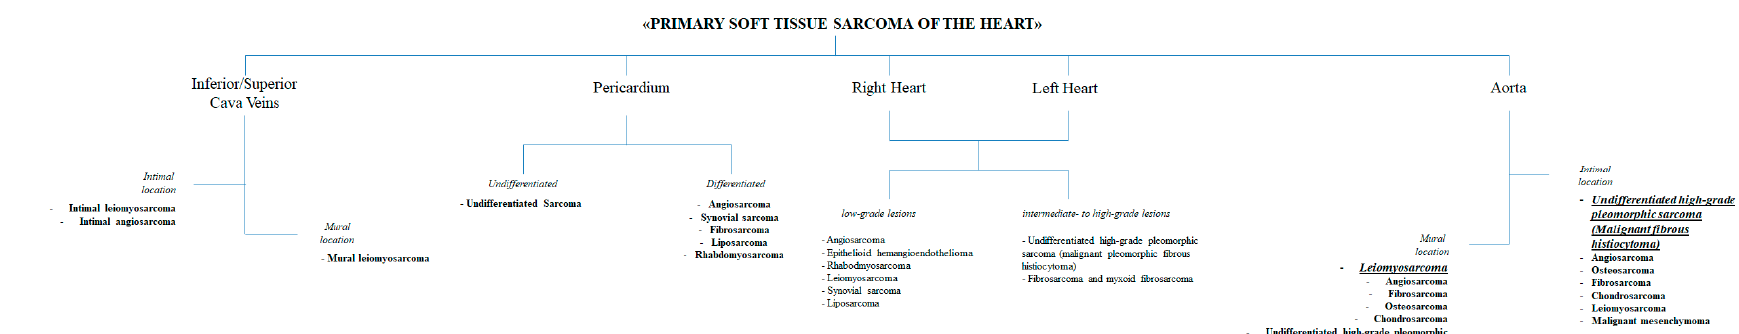
Figure 1. Classification of the primary soft tissue sarcoma of the heart. The figure gathers the combination of the surgical and histologic approach to the classification of these neoplasms. Cardiac sarcomas are differentiated according to the site of origin into cardiac chambers and great arteries/veins; then, sarcomas are identified in agreement with their own histologic nature.